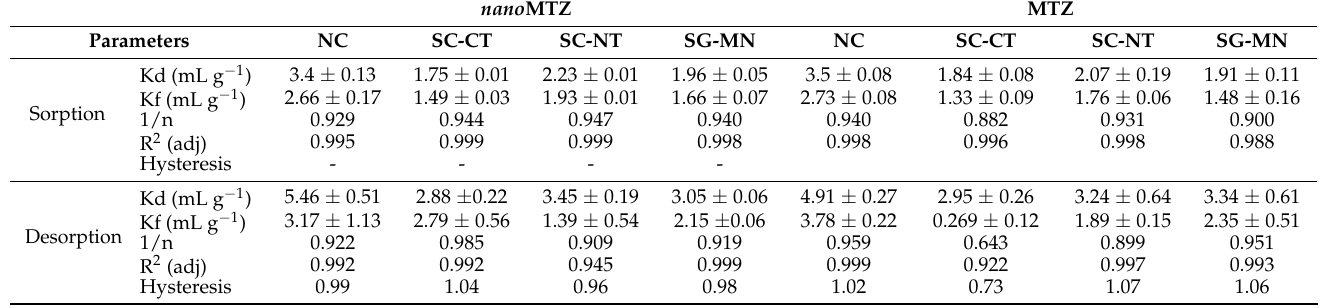
Table 1. 14 C-metribuzin sorption isotherm parameters for two formulations ( nano MTZ and conven- tional MTZ) based on the Freundlich model, in different soil systems (non-crop soil—NC, cultivated soil with soybean–corn succession in a no-tillage system—SC-NT, cultivated soil with soybean–corn succession in a conventional tillage system—SC-CT and, sugarcane monoculture soil—SG-MN. The data indicate the parameter mean ± standard error ( n = 2). Kd—sorption distribution coef- ficient. Kf—Freundlich equilibrium constant. 1/n—is the degree of linearity of the isotherm. R 2 (adj)—adjusted coefficient of determination.